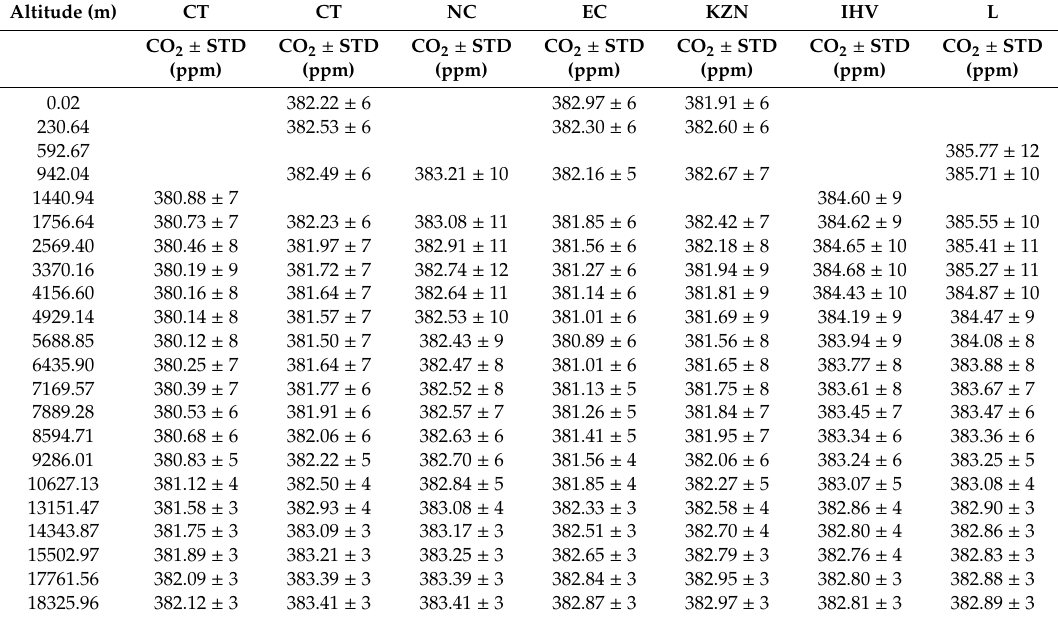
Table A1. Summer (DJF) horizontally averaged CO 2 data and the associated standard deviations at di ff erent altitudes used for vertical profiles at di ff erent study areas. Altitude